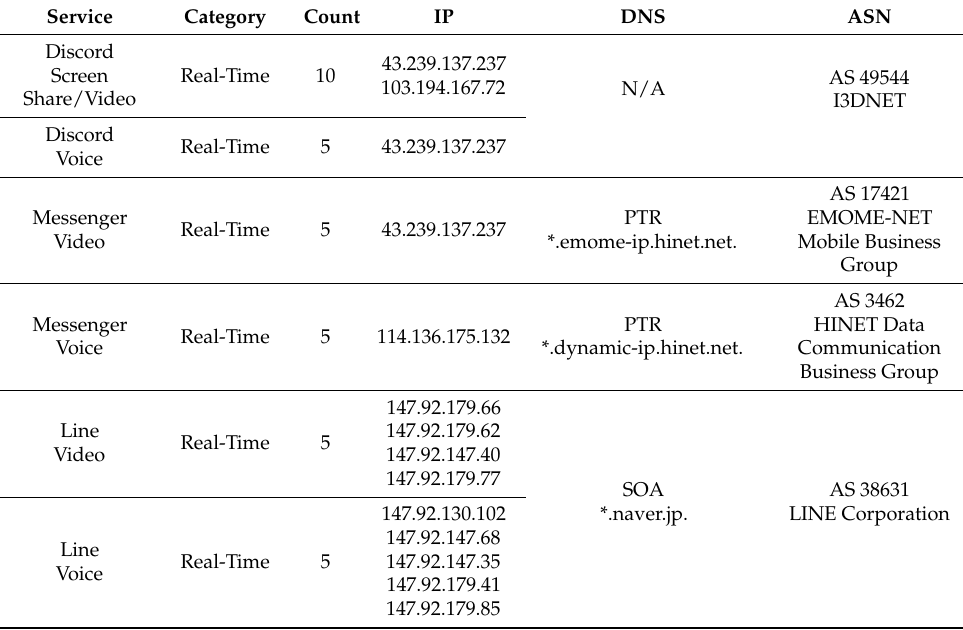
Table 13. Real-time category IP/ASN query results. * stands for